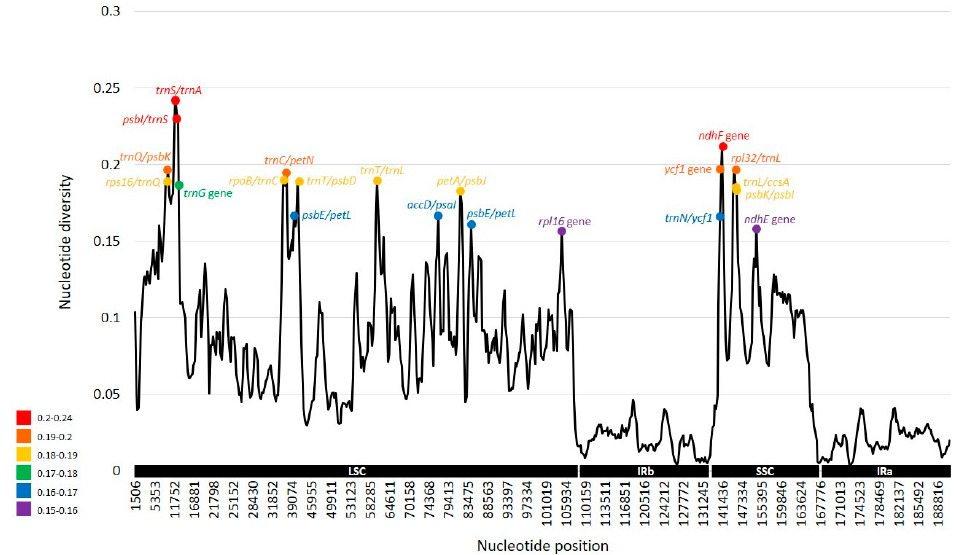
Figure 5. Sliding window analysis of the whole chloroplast genomes of nine Araceae